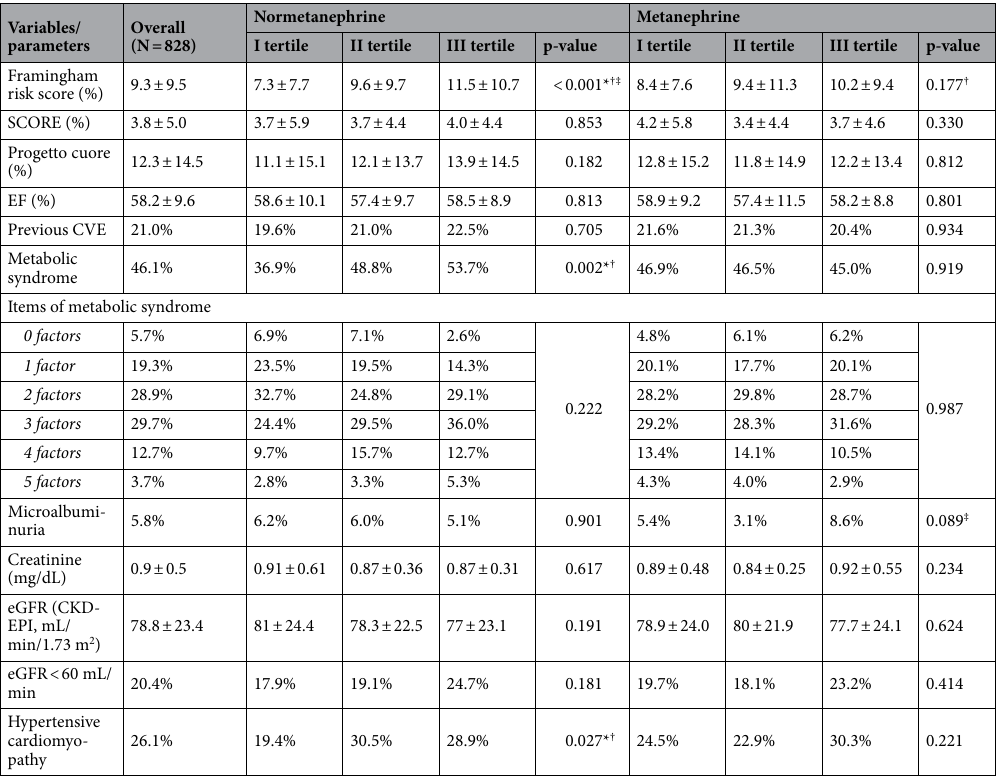
Table 3. Cardiovascular risk scores and cardiometabolic complications according to tertiles of normetanephrine and metanephrine levels. Abbreviations: CKD-EPI, chronic kidney disease epidemiology collaboration; CVE, cardiovascular events; EF, ejection fraction; eGFR, estimated glomerular filtration rate. The table shows p-values of the statistics analyzing differences between the three tertiles. *Significant difference between I tertile and II tertile. † Significant difference between I tertile and III tertile. ‡ Significant difference between II tertile and III tertile.